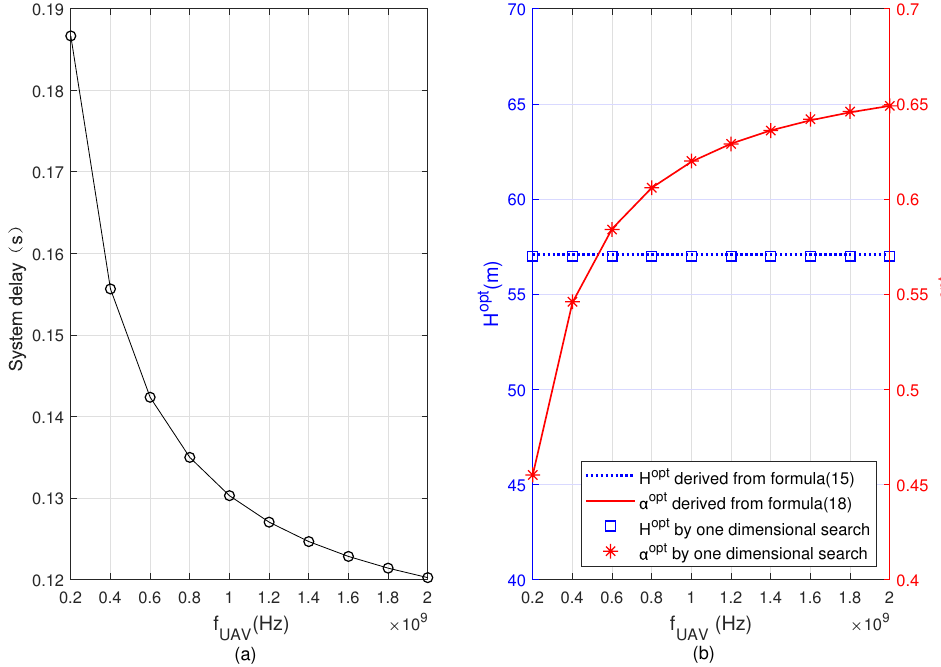
Figure 8. Minimum system delay, optimal flying altitude, and optimal task allocation ratio versus the CPU frequency allocated for computation on the UAV. ( a ) Minimum system delay, ( b ) optimal flying altitude and optimal task allocation